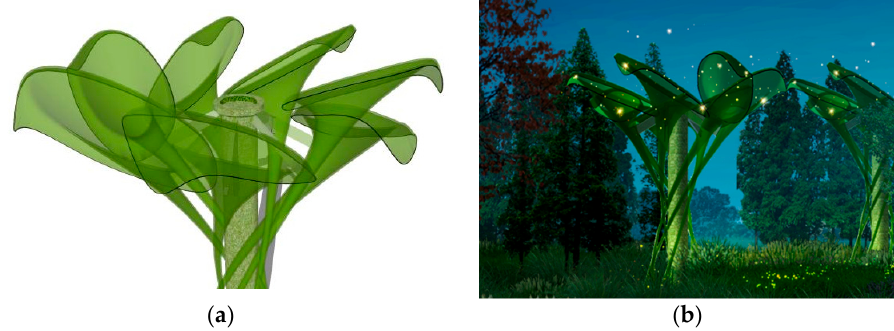
Figure 21. The color and material presentation of products: ( a ) daytime, and ( b )